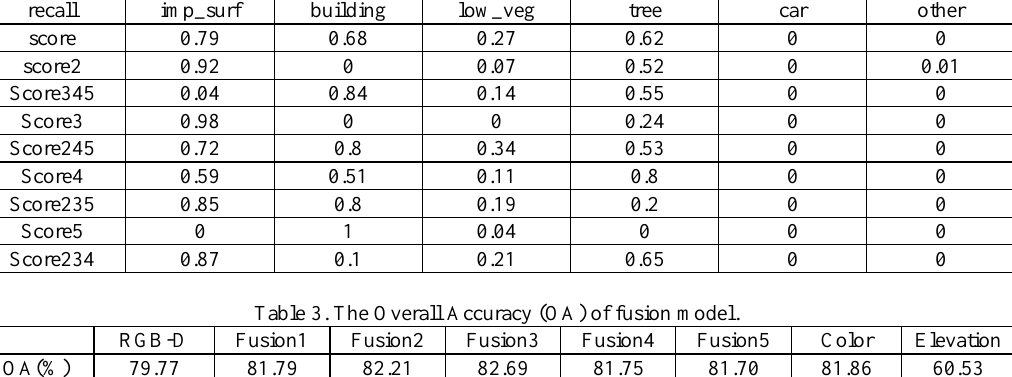
Table 2. The recall of different layers for different classes of elevation features.